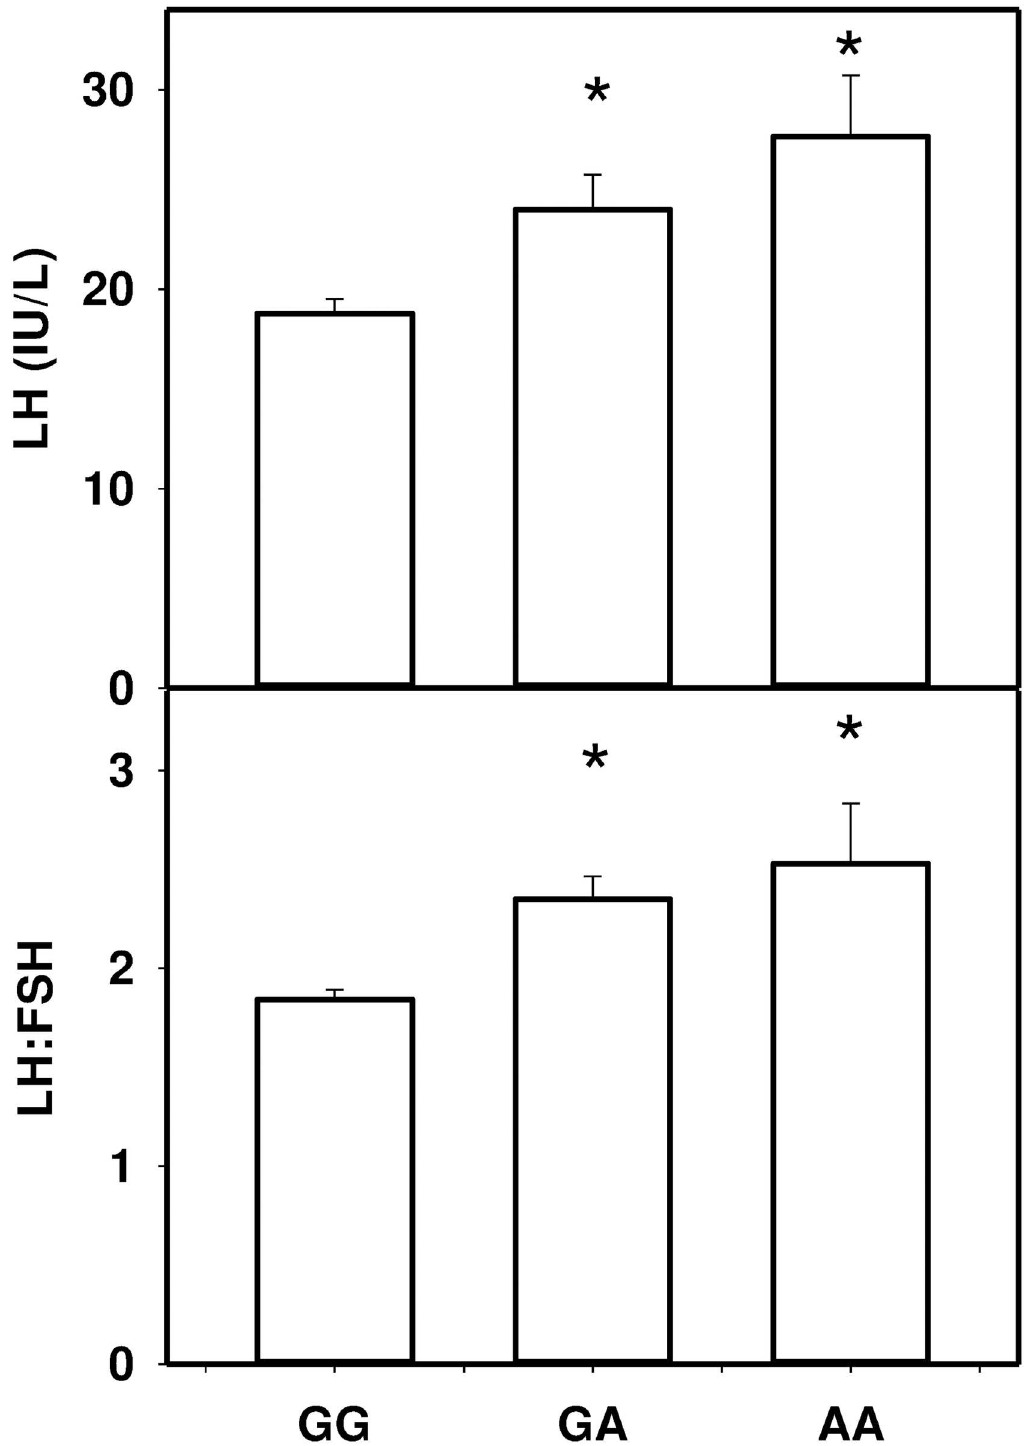
Fig 1. LH and the LH:FSH ratio as a function of genotype at rs11031006 in PCOS and control subjects. * p < 0.05.